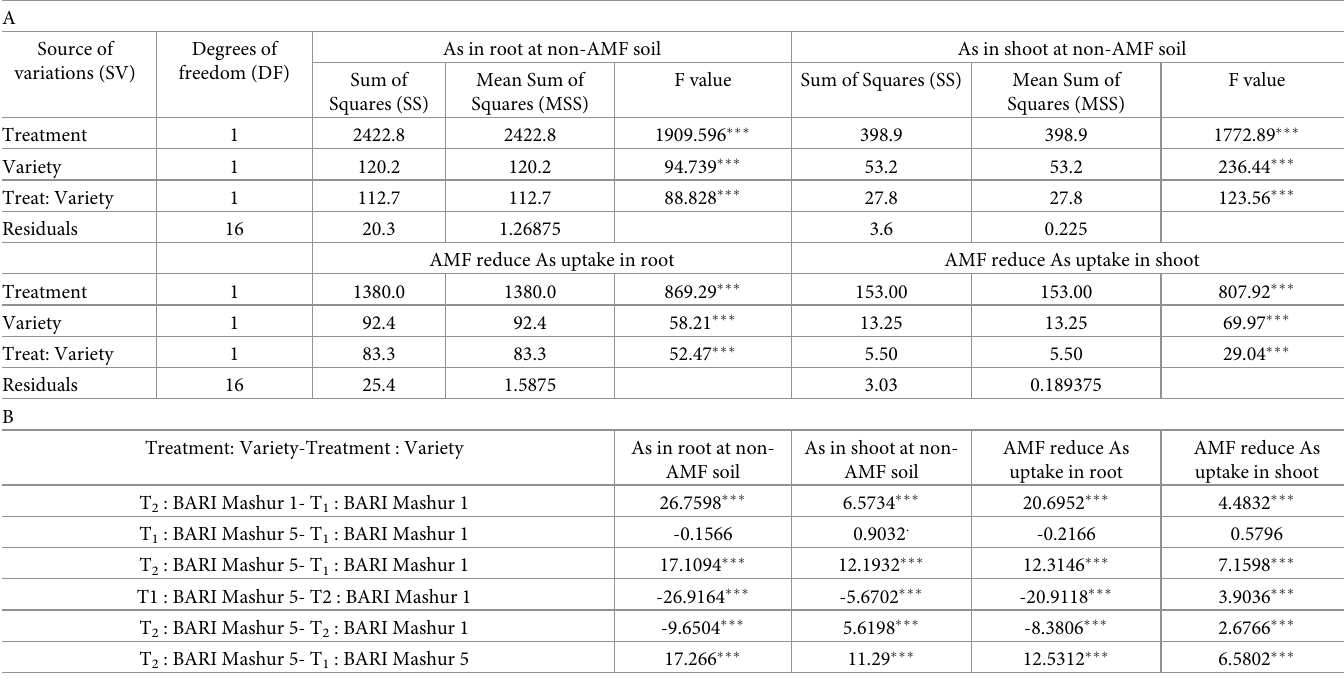
Table 4. AMF reduce As uptake in root and shoot of lentil